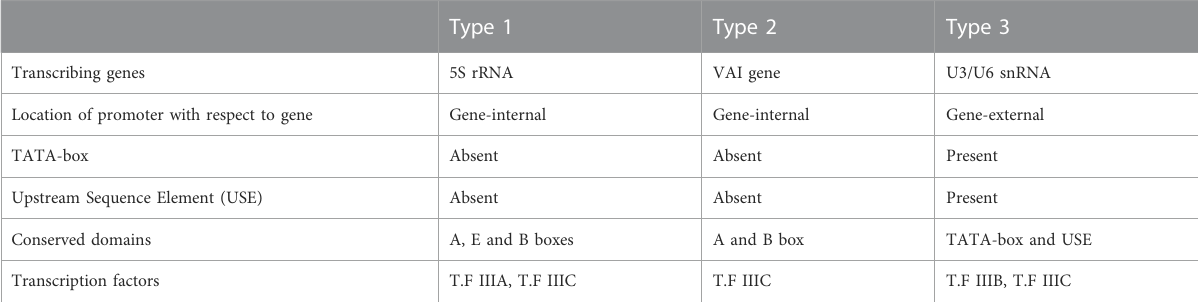
TABLE 2 Types of RNA Pol III